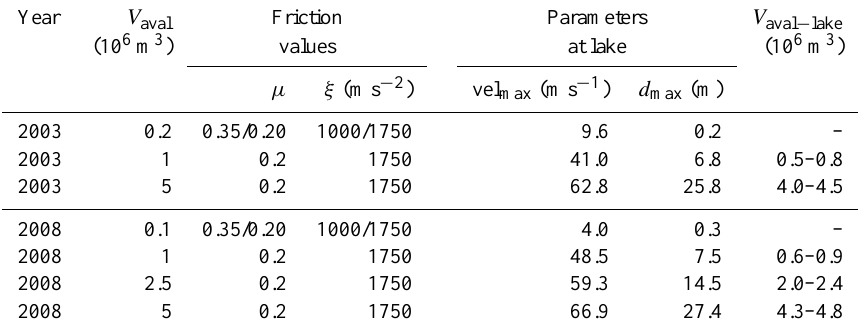
Table 5. Results of the avalanche dynamics calculations for different scenarios and surface geometries of Triftgletscher in 2003 and 2008 ( V aval : total ice avalanche volume, V aval − lake : ice avalanche volume reaching the lake, vel max and d max : velocity and flow depth of the avalanche entering in the